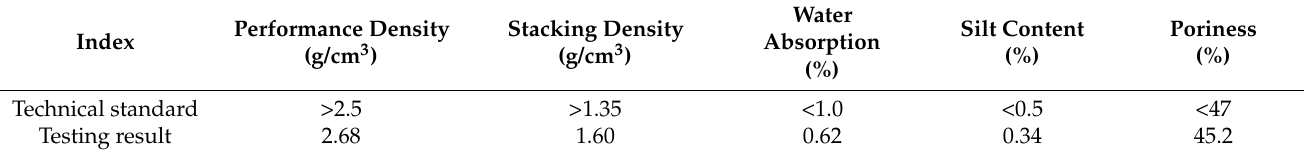
Table 3. Detection indexes of limestone